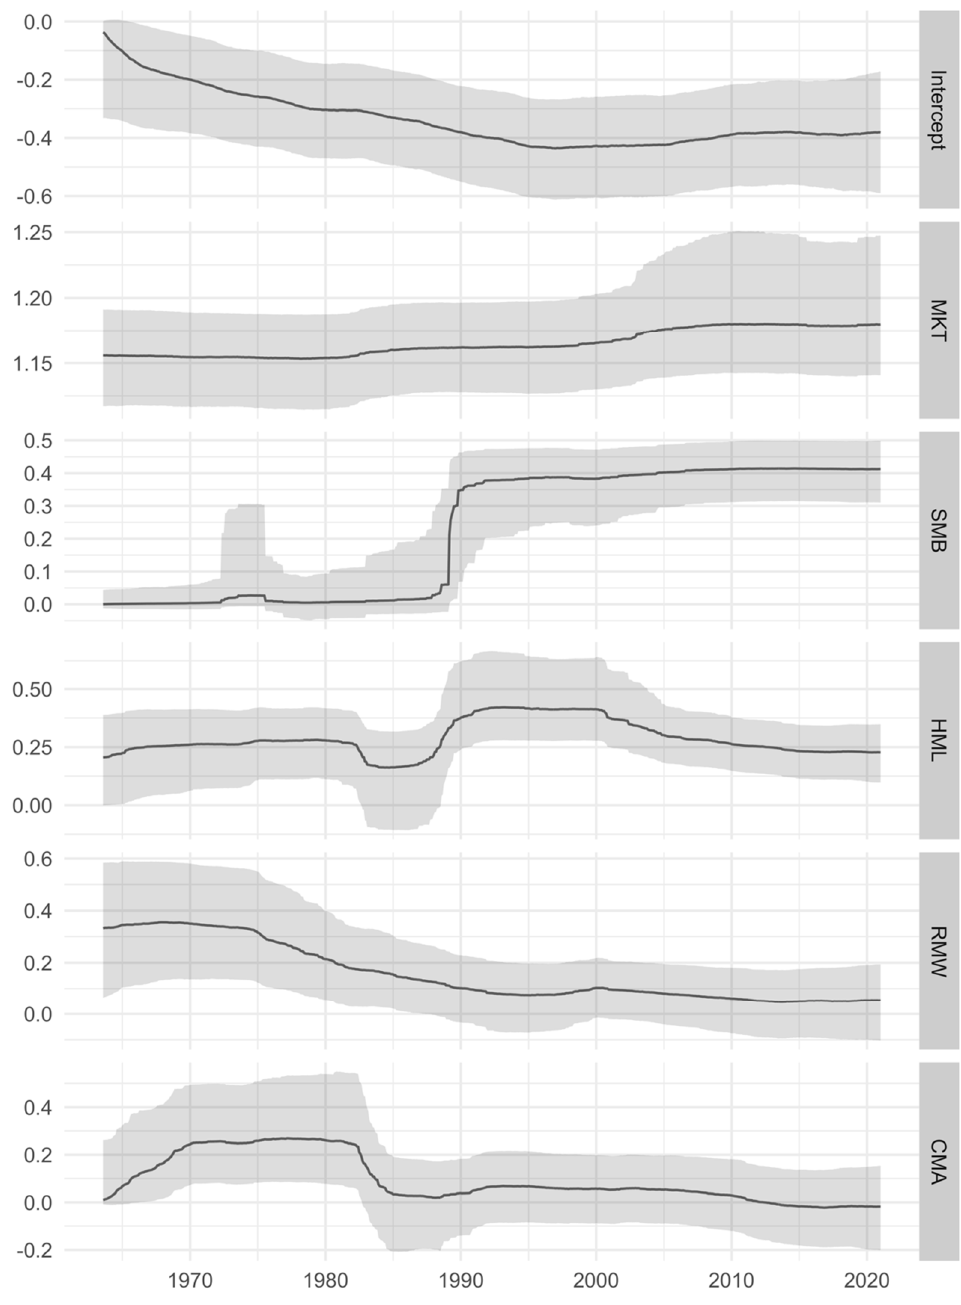
Figure 2. Threshold time-varying parameter beta estimates—Consumer Durables. Note: The figure presents the plots for the posterior medians (solid line) with 68% confidence bands (gray shaded region) of the time varying beta estimates from the TTVP model with stochastic volatility. Gibbs sampling is used with 10,000 posterior and 10,000 burn-in draws. MKT, SMB, HML, RMW and CMA represent the Market, Size, Book-to-Market, Profitability and Investment factors based on the five-factor specification of Fama and French [57].